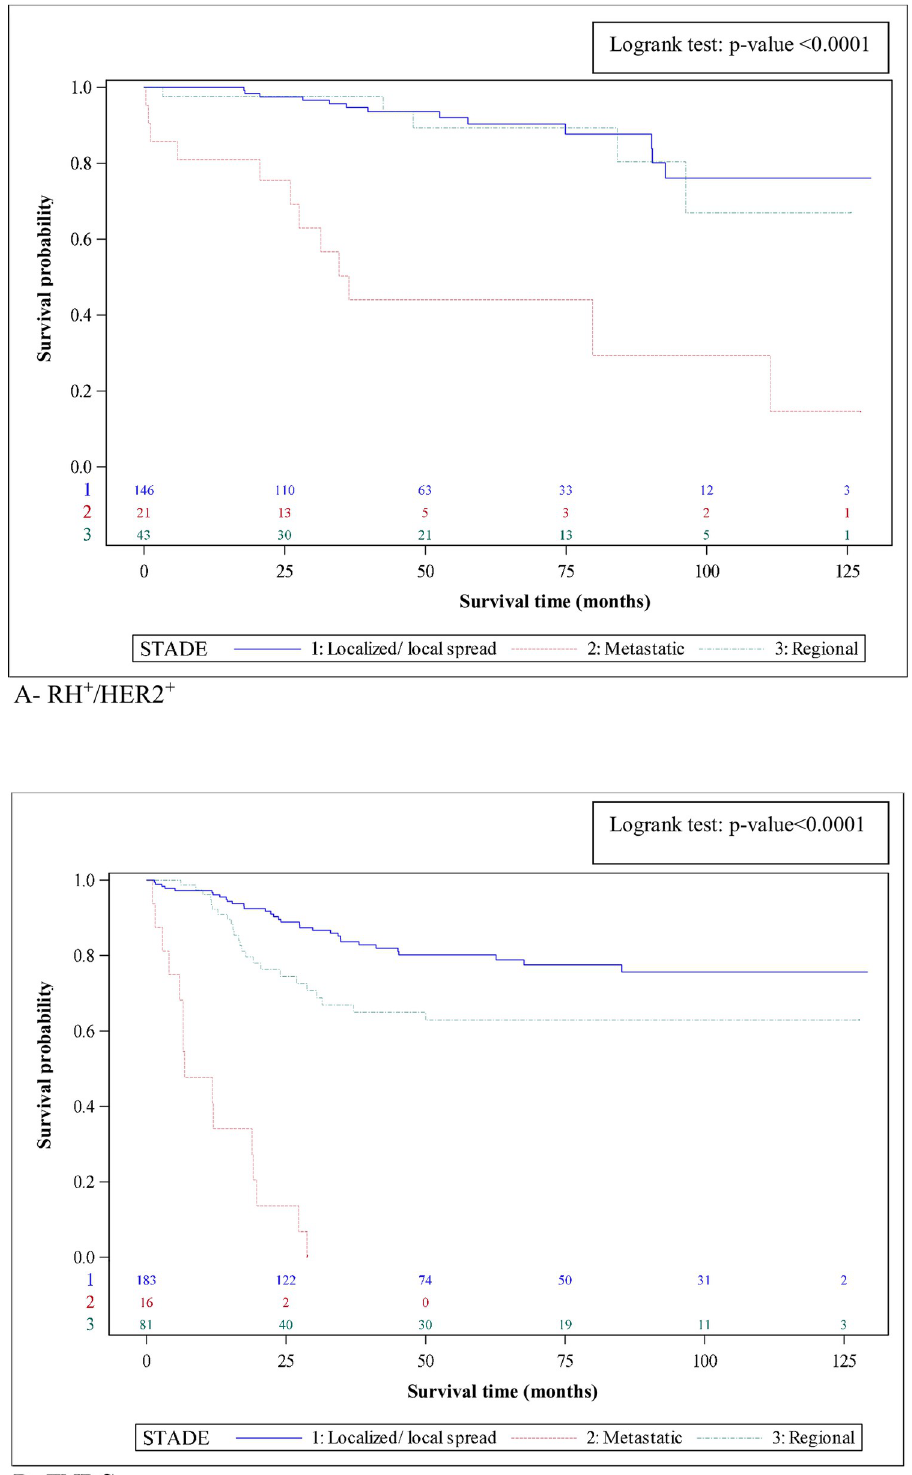
Fig 3. Overall survival in breast cancer patients, subtypes TNBC (A) and HR+/HER2+ (B) stratified by ENCR staging, Martinique, 2008–2017.